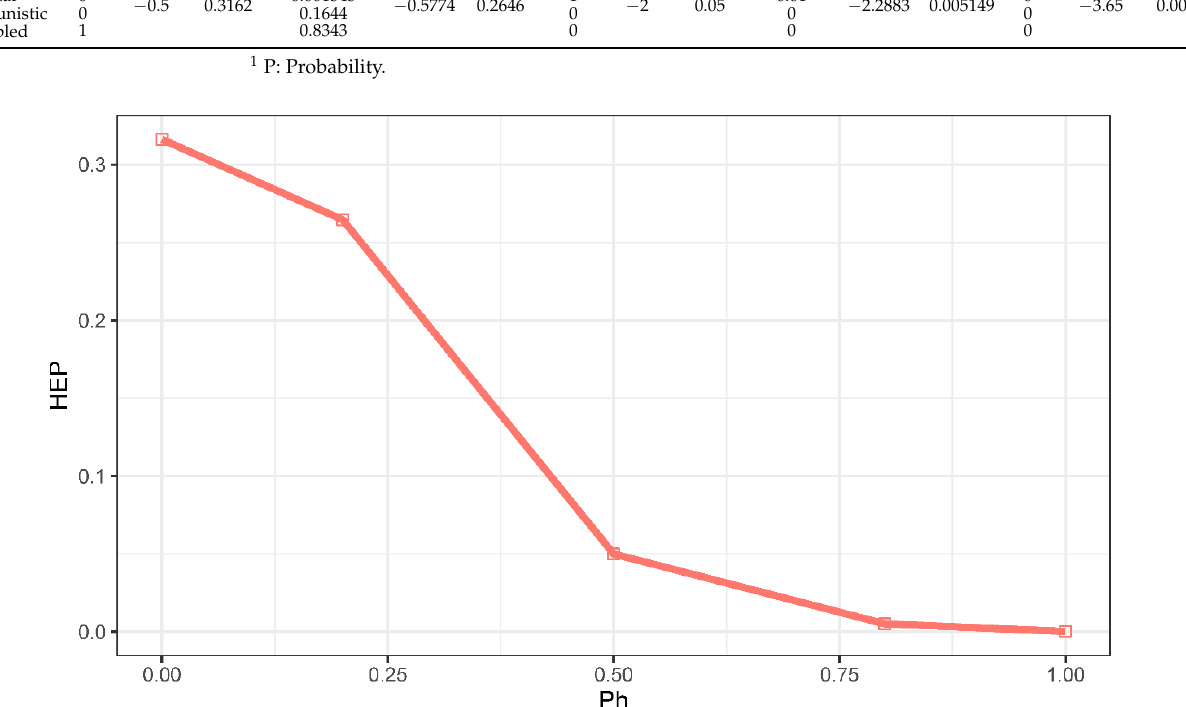
Figure 11. The relationship between the human error probability (HEP) and the homogenized probability of the common performance condition indicators (CPCs). Table 11. The probabilities of the common performance condition indicators (CPCs) for five cases.